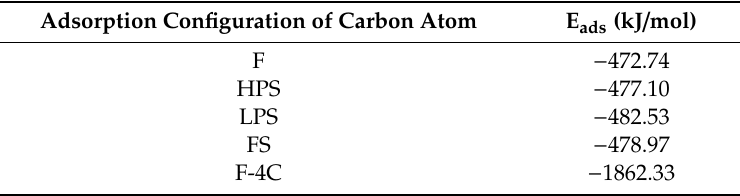
Table 1. The adsorption energy, E ads , for carbon atoms on the pyrite surface.